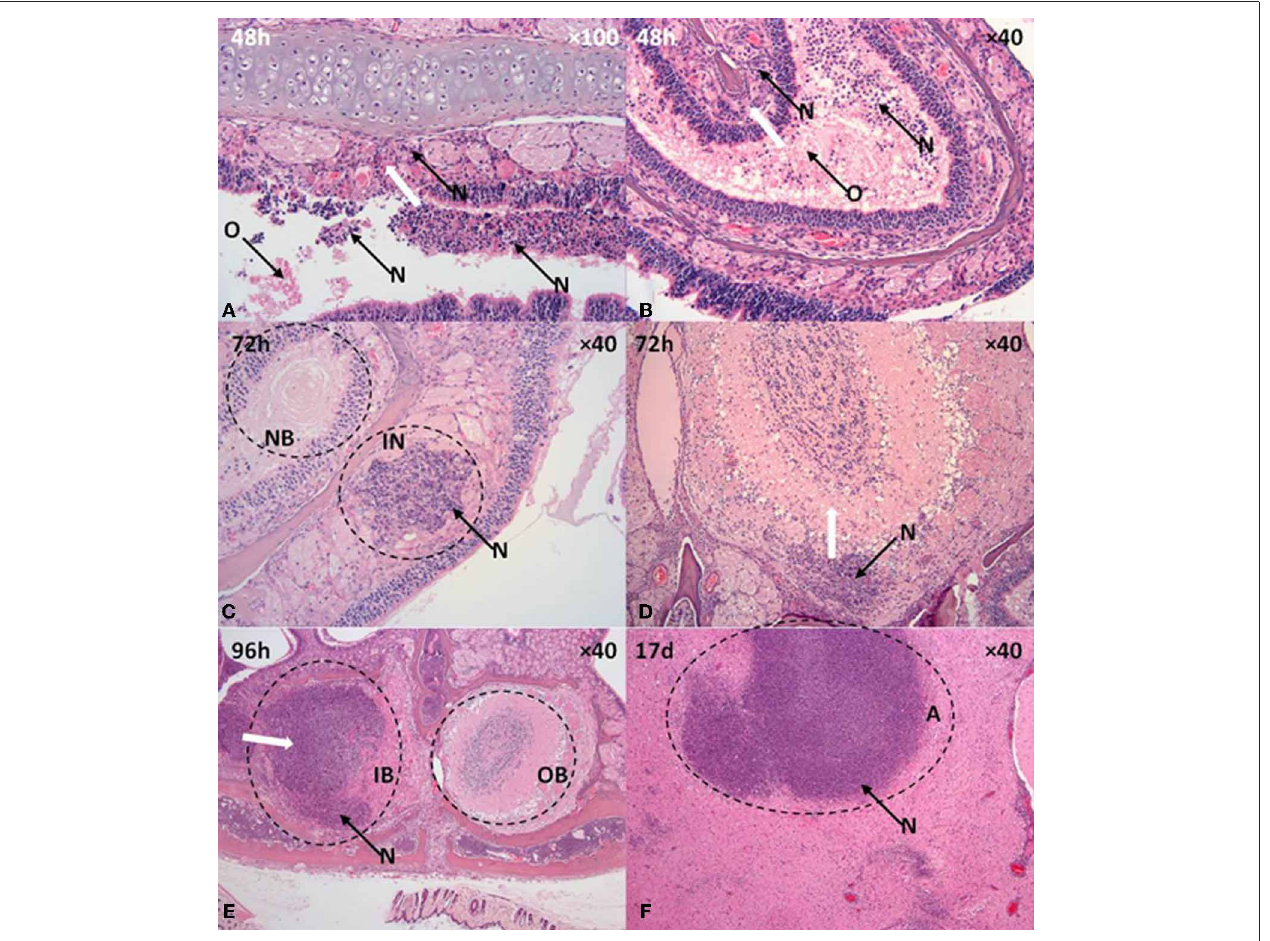
FIGURE 5 | Olfactory and neurological pathology in mice that inhaled B. pseudomallei K96243 in 12 µ m aerosol particles. (A,B) Olfactory epithelium, (C,D) Olfactory nerves, (E) Olfactory bulb, (F) brain. A, abscess,